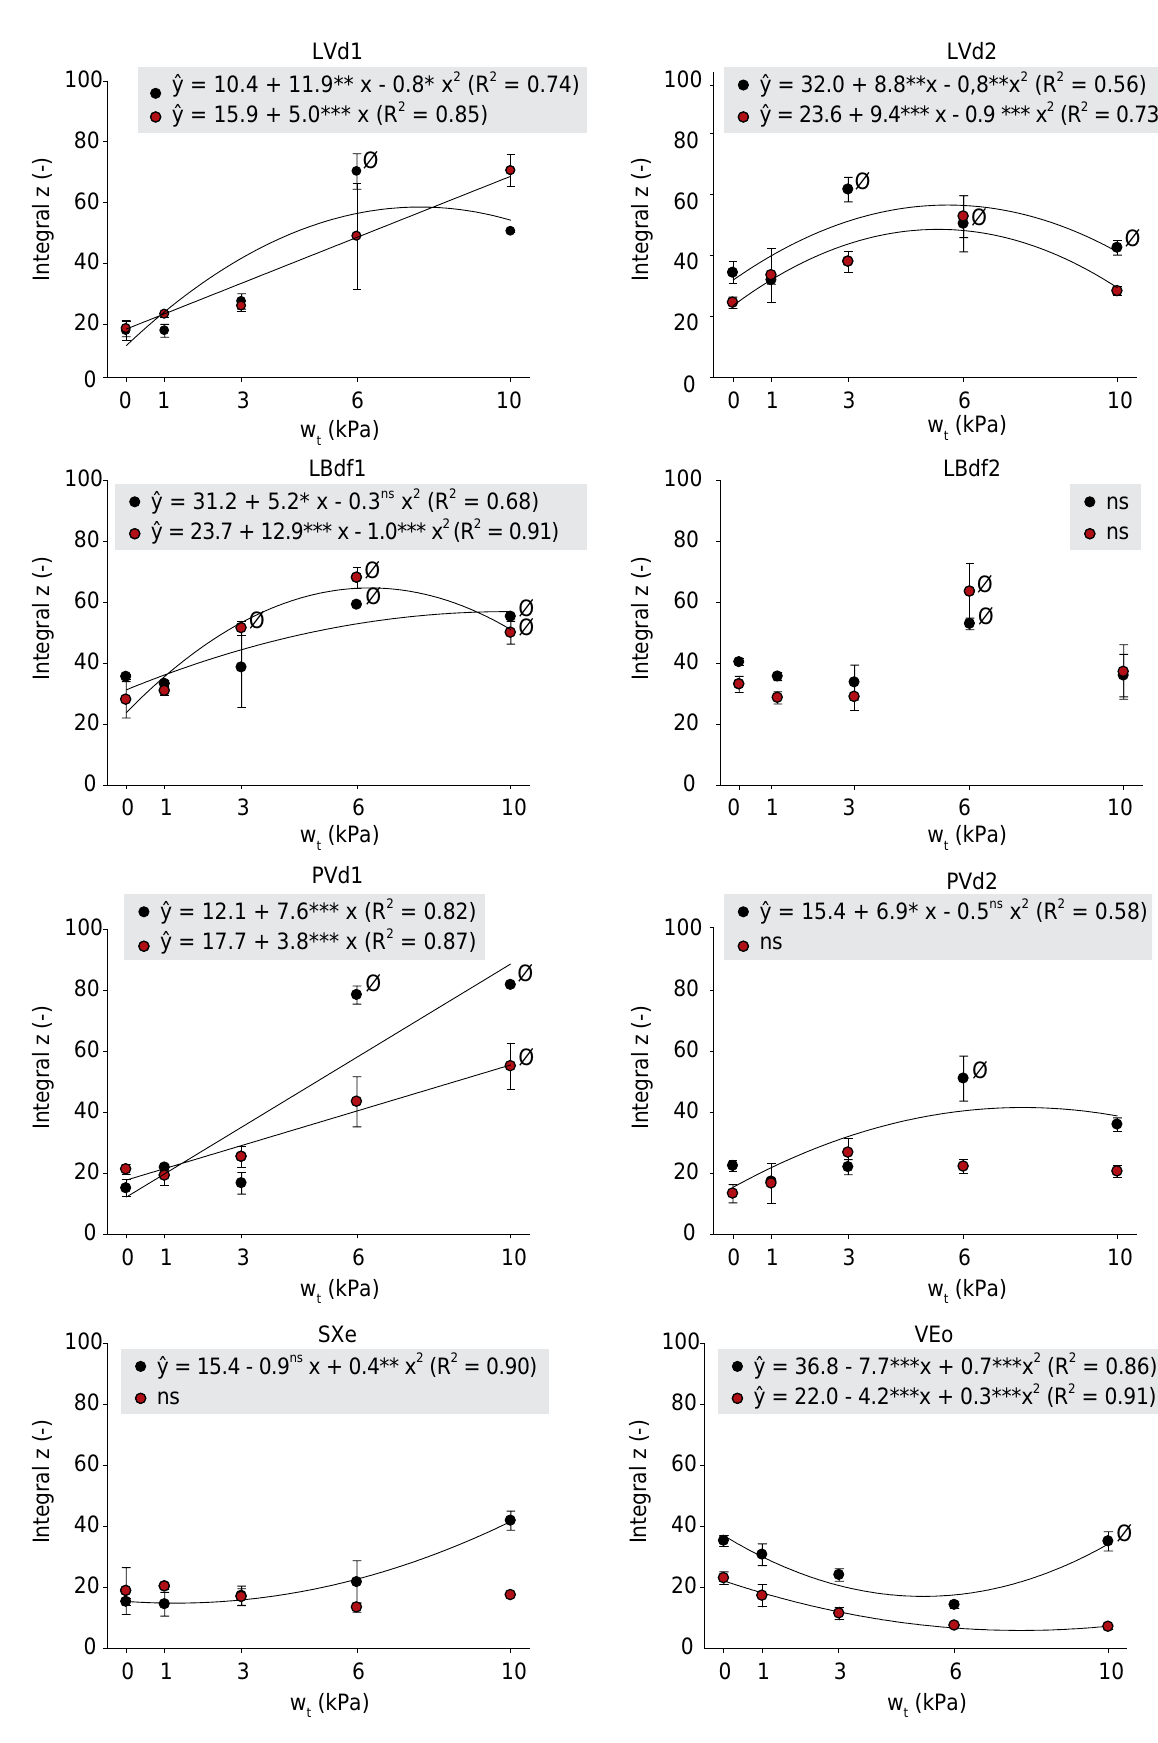
Figure 4. Integral z as a function of soil water tension (w t ) for A horizons (black symbols) and B horizons (red symbols) of Latossolos /Oxisols (LVd1, LVd2, LBdf1, LBdf2), Argissolos /Ultisols (PVd1, PVd2), Planossolo /Alfisol (SXe), and Vertissolo /Vertisol (VEo). *, ** and ***: significant at 5, 1 and 0.1 %, respectively; ns: not significant; Ø: yield point not